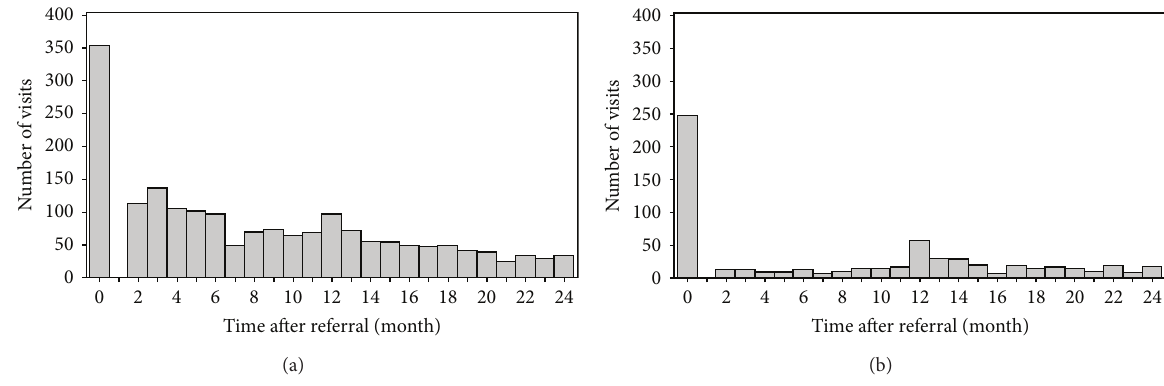
Figure 1: Distribution of time at visits for OSA and comparison groups: (a) OSA group (1,855 visits by 338 children); (b) comparison group (615 visits by 245 children).